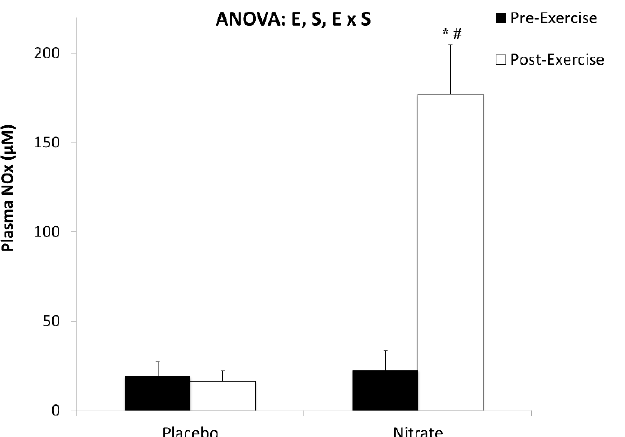
Figure 2. Effects of exercise and oral nitrate supplementation on nitrite and nitrate (NO x ) plasma levels from metabolic syndrome patients. Results represent mean ± SEM. Statistical analysis: two- way ANOVA. Letters indicate significant effects of exercise (E) or supplementation (S) or significant interaction of the two ANOVA factors (E x S). * Significant differences with respect to placebo; (#) significant differences with respect to pre-exercise, p < 0.05.